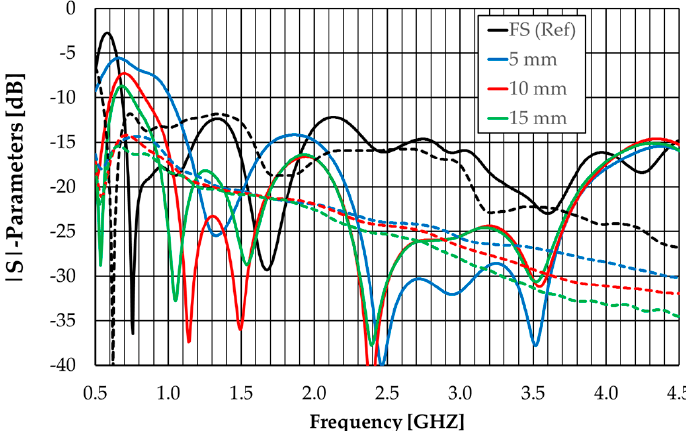
Figure 17. |S|-parameters’ simulation results of the modified octagonal monopole with absorber and metal shield, for different absorber thicknesses. |S ii |—solid lines, |S 12 |—dashed lines. An absorber thickness of 10 mm provides |S 11 | (and |S 22 |) below − 10 dB except in an absorber thickness of 10 mm, the mutual coupling is below − 14.2 dB.